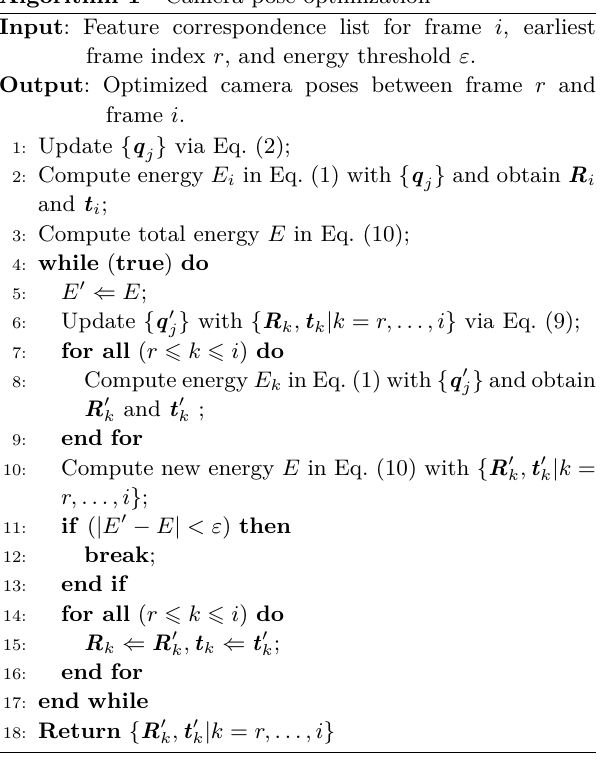
Algorithm 1 Camera pose